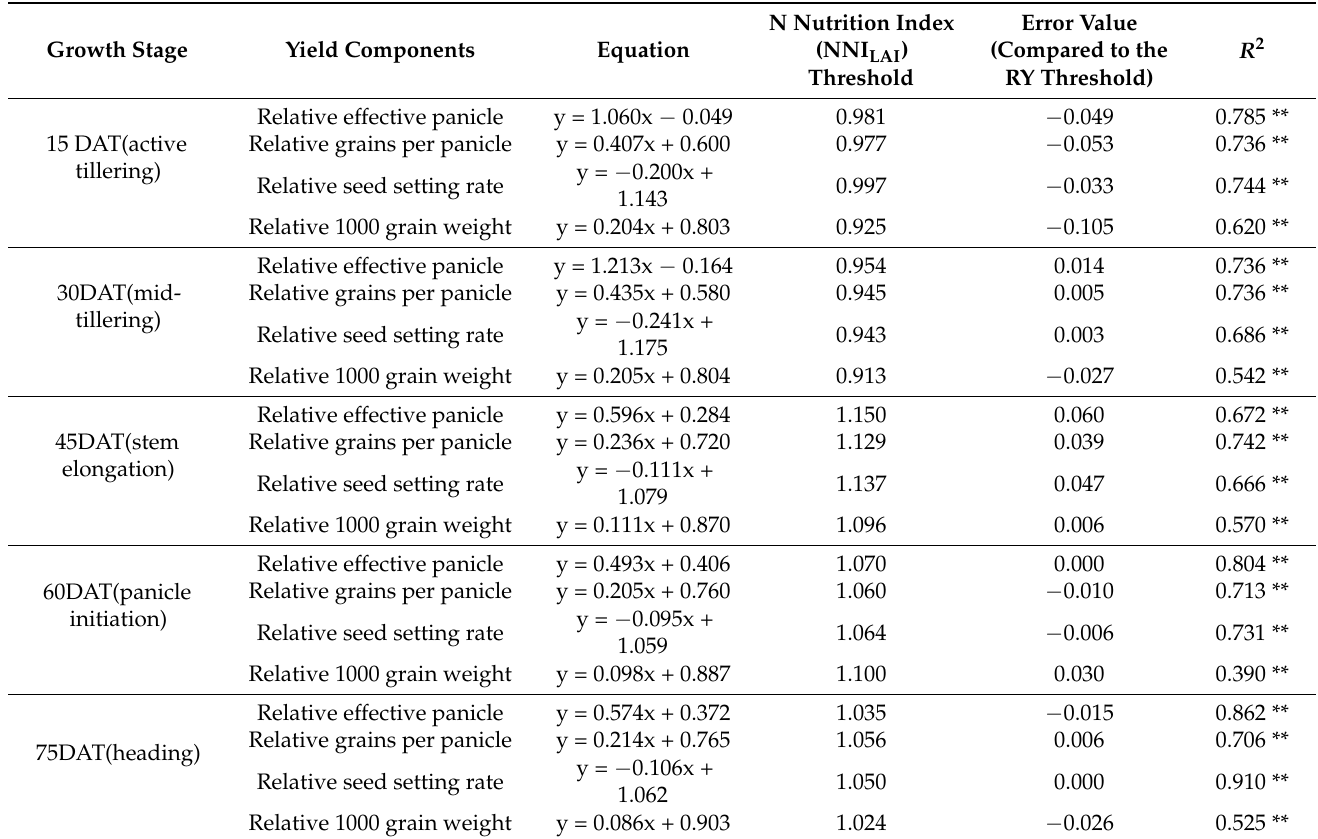
Table 4. Correlation between the NNI DM and the relative yield components of the indica hybrid rice grown from machine-transplanted bowl seedlings according to growth stage. ** indicates significance at 0.01